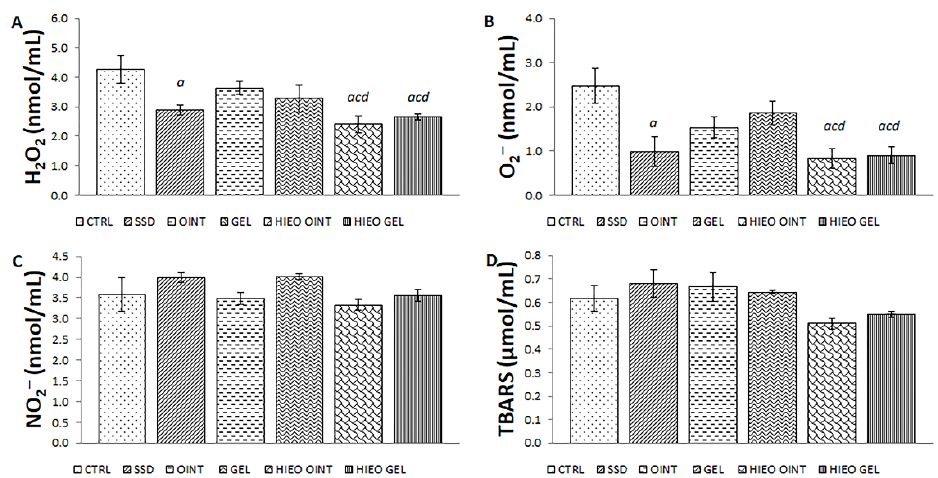
Figure 4. Effects of applied formulations on the pro-oxidative markers: ( A ) H 2 O 2 − ( B ) O 2 − ; ( C ) NO 2 − ; ( D ) TBARS. Values are expressed as mean ± standard deviation. Values p < 0.05 were considered to be statistically significant. a Statistical significance in relation to CTRL group; c Statistical significance in relation to OINT group; d Statistical significance in relation to GEL group.